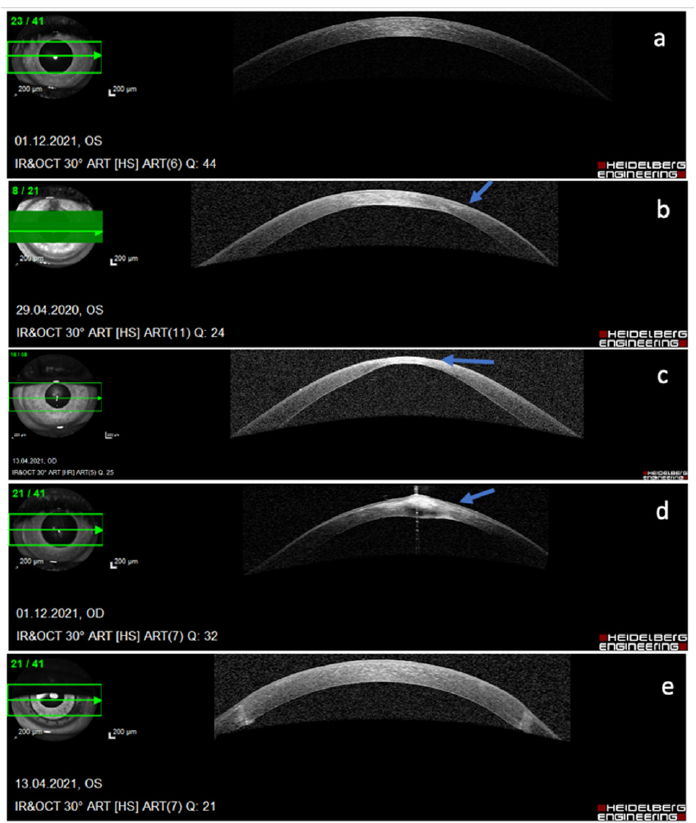
Figure 2. Different stages of keratoconus as demonstrated by anterior segment optical coherence topography (AS OCT) of the cornea: ( a ) sub-clinical stage, no changes seen on AS OCT, ( b ) thinning of the stroma at the cone with compensatory epithelial thickening (arrow), ( c ) significant thinning and bulging of the cone (arrow), ( d ) bulging, hydrops, and fibrosis of the cone (arrow), ( e ) end-stage keratoconus treated with penetrating corneal transplantation.